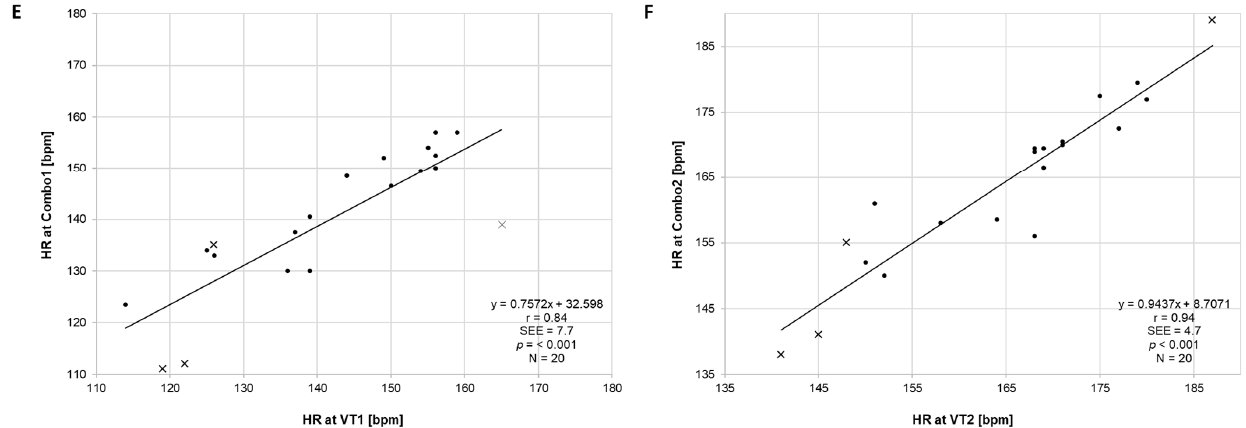
Figure 2. Linear regression of HR for VT1 vs. HRVT1 ( A ), VT2 vs. HRVT2 ( B ), VT1 vs. EDRT1 ( C ), VT2 vs. EDRT2 ( D ), VT1 vs. Combo1 ( E ), and VT2 vs. Combo2 ( F ) with standard error of estimate (SEE), Pearson’s r, and total tests compared (N). Combo values based on only a single threshold modality (EDRT) are represented as “×”.